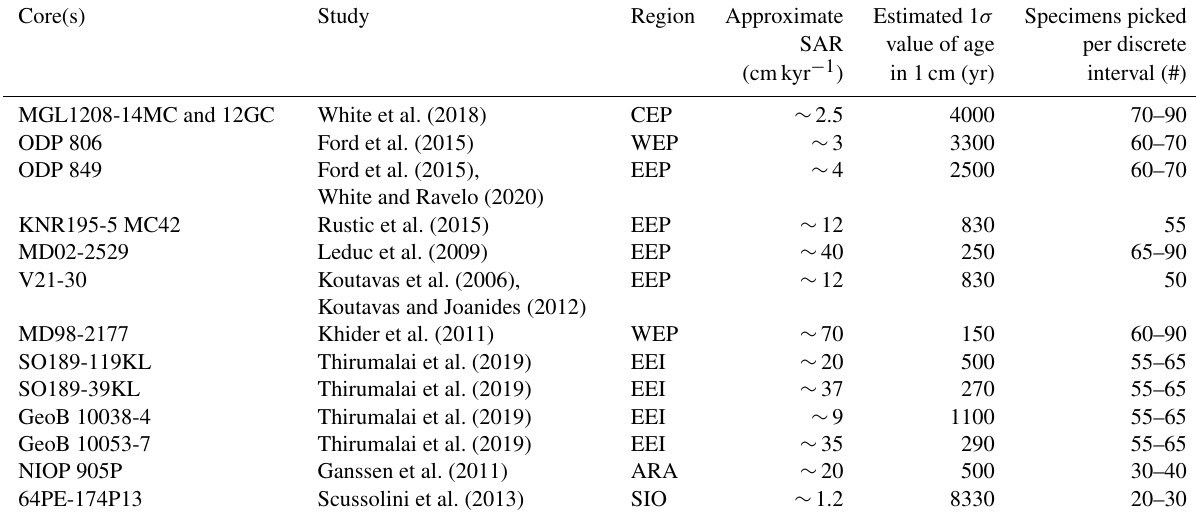
Table 1. Overview of SAR and number of picked specimens in select IFA studies (including non-ENSO studies). Region codes are as follows: WEP – western equatorial Pacific; CEP – central equatorial Pacific; EEP – eastern equatorial Pacific; EEI – eastern equatorial Indian Ocean; SIO – southern Indian Ocean; ARA – Arabian Sea. We have estimated the 1 σ value of age in 1cm of sediment based on the SAR and a BD of 10cm (Boudreau, 1998), using the following calculation based on (Berger and Heath, 1968): BD/SAR × 1000, where SAR is entered in cmkyr − 1 and BD in